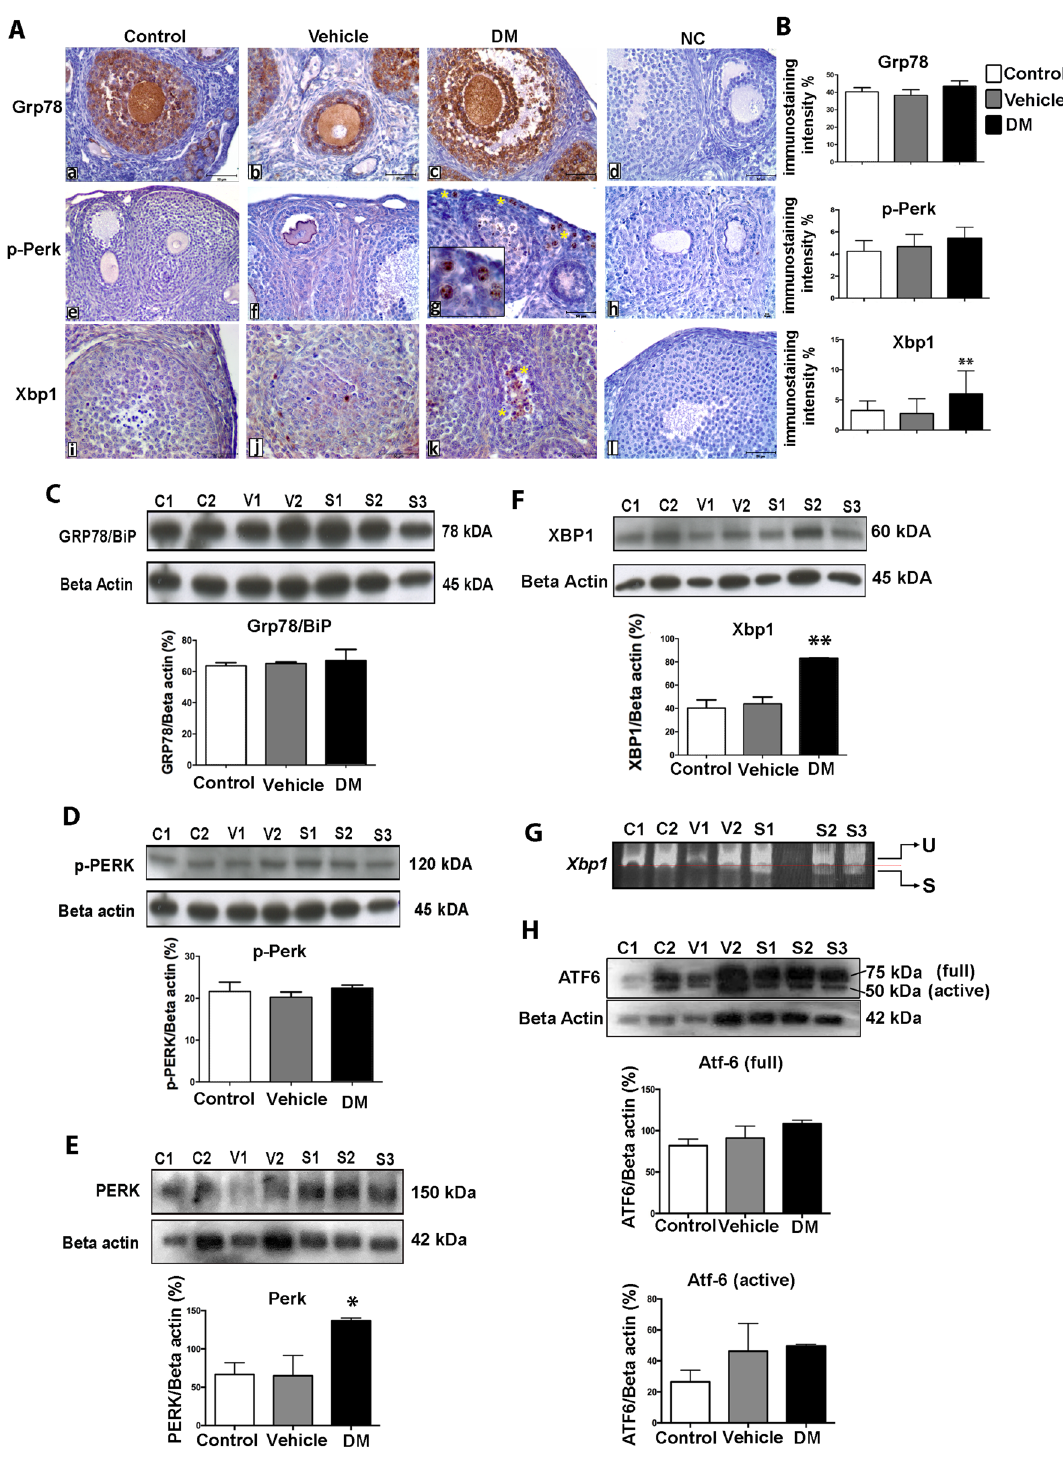
Figure 2. ER stress related IRE1α/XBP1 branch of the UPR is activated in mice ovaries with type 1 DM. (A) The expression of Grp78 (a–b–c), p-Perk (e–f–g) and Xbp1 (i–j–k) proteins in control, vehicle and DM group ovaries. Of note, p-Perk is specifically noted only in primordial follicles from DM exposed ovaries (g, zoomed inset). Additionally, accumulated Xbp1 nuclear expression in GCs was noted in the ovaries with DM (yellow asterisks). NC negative controls (d–h–l). Scale bars = 50 µm. ( B) Histograms show immunostaining intensities for Grp78 (top), p-Perk (middle) and Xbps1 (bottom) proteins that were obtained using Image J software. One-way ANOVA followed by TUKEY’s multiple comparisons test, ** P = 0.0011 (n = 6 per group). Columns are means ± SD. ( C–F, H) Total protein quantification of Grp78/BiP (C) , p-Perk (D) , PERK (total form, E ), Xbp1 (F) and Atf6 ( H , full and active form) analysed by Western Blotting in ovaries (for the original images for blots please see Supplementary Fig. 1). C control (n = 4); V vehicle (n = 4); S STZ-induced (n = 6). Beta actin is used as an internal control. One-way ANOVA followed by TUKEY’s multiple comparisons test, * P = 0149, ** P = 0.0093. Columns are means ± SD. G. A representative image of Xbp1 RT-PCR products from ovary groups, C control, V vehicle, S STZ-induced, U unspliced Xbp1 (343 bp), S spliced Xbp1 (327